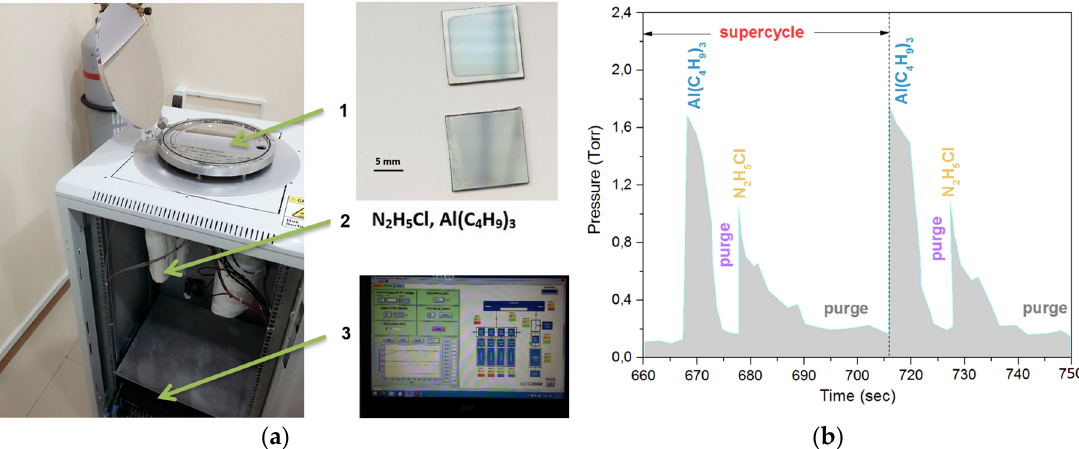
Figure 1. ( a ) Atomic layer deposition (ALD) equipment and its main units: 1—vacuum chamber, 2—section for containers with precursors, 3—controller with a custom-built software; ( b ) Dependency of the chamber pressure on the precursor exposure time.